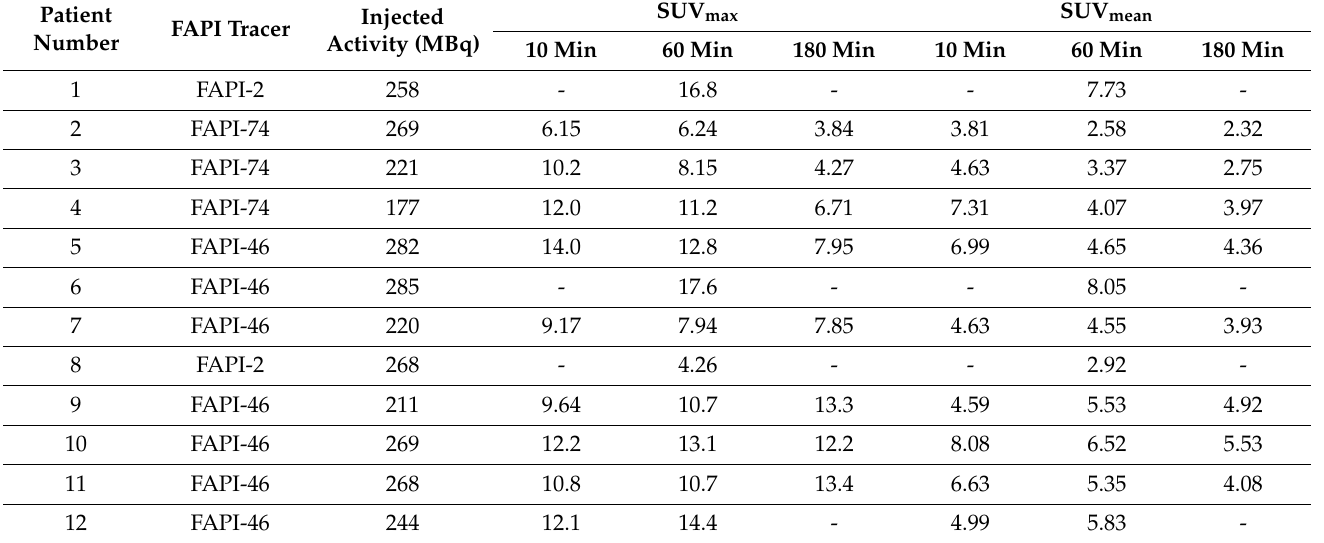
Table 2. 68 Ga-FAPI PET/CT imaging protocols of 12 patients with